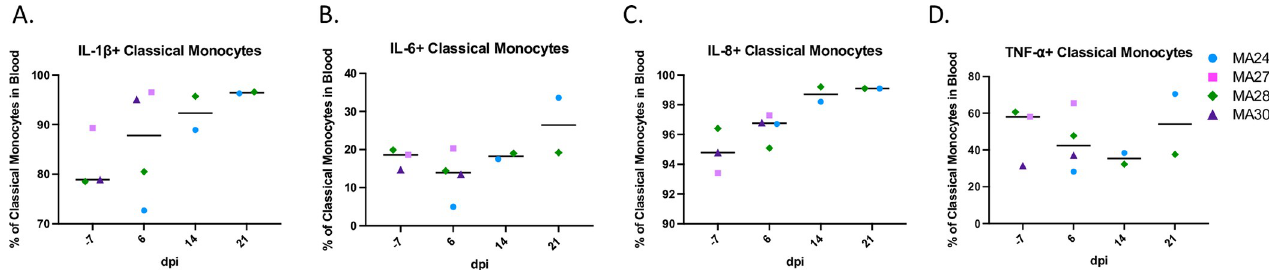
Fig 5. Monocyte cytokine response in the blood of pigtail macaques challenged with SARS-CoV-2. A-D. Frequency of IL-1 β (A), IL-6 (B), IL-8 (C) and TNF- α (D) expressing classical monocytes (CD45+ HLA-DR+ CD14- CD16+) in the blood. Bars represent median. Day 0 = day of infection. Baseline (-7): n = 3, Day 6: n = 4, Day 14: n = 2, Day 21: n = 2.